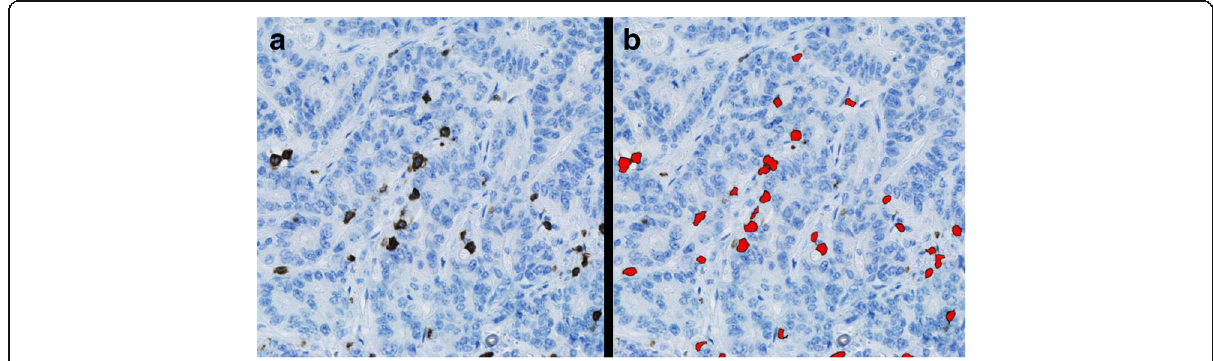
Fig. 5 Example of the processing of the image analysis. a ) Part of a CD3 stained section. b ) CD3+ lymphocytes labelled with the red color are counted by the